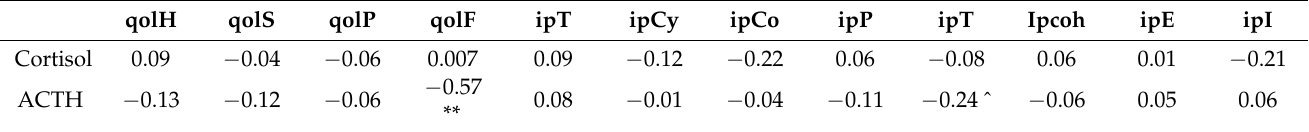
Table 5. Correlations between quality of life, illness perception dimensions and stress hormones.